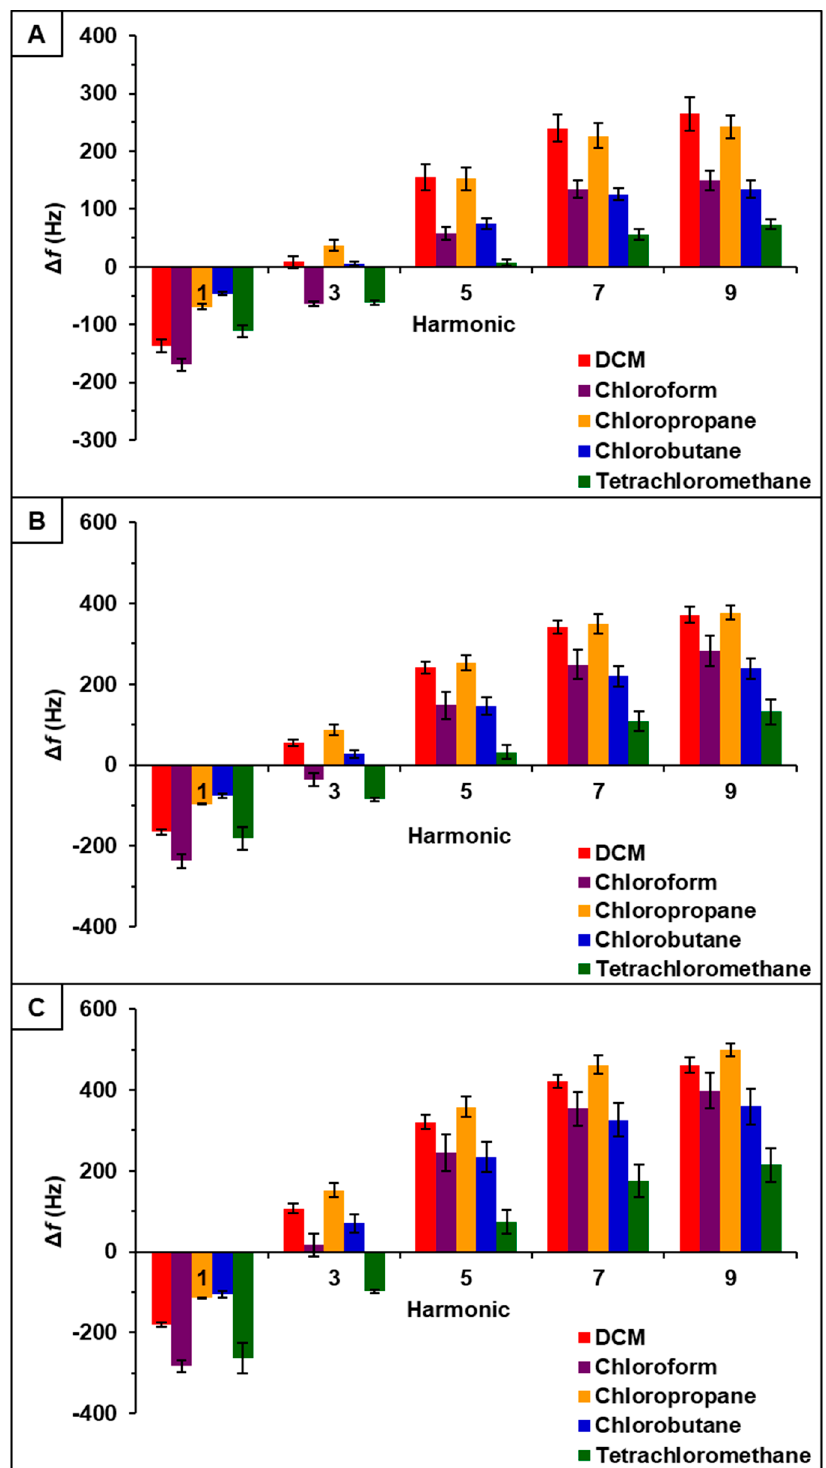
Figure 3. [P 66614 ][DBS]-PDMS sensor response to chlorinated VOCs at multiple harmonics at ( A ) 0.2 flow ratio, ( B ) 0.3 flow ratio, and ( C ) 0.4 flow ratio. Error bars represent standard deviation for three replicate measurements.